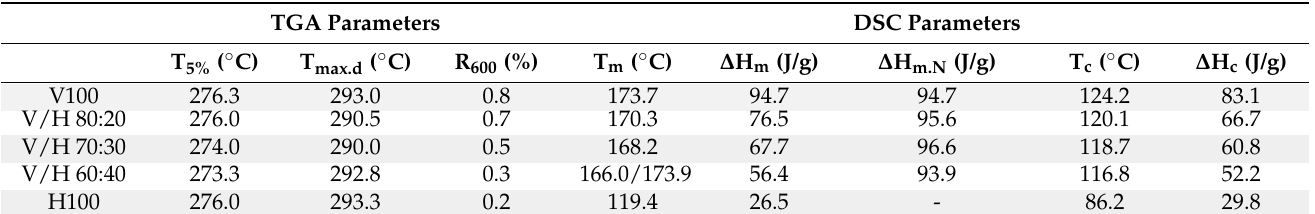
Table 2. Thermogravimetrical analysis (TGA) and differential scanning calorimetry (DSC) data for poly(3-hydroxybutyrate- co -3-valerate) (PHBV), poly(3-hydroxybutyrate- co -3-hydroxyhexanoate) (PHBH), and their